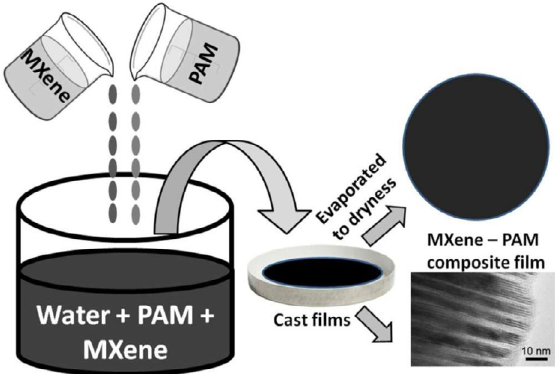
Schematic of the synthesis of MXene–PAM nanocomposite films. Reproduced with permission from Ref. [181], © Royal Society of Chemistry